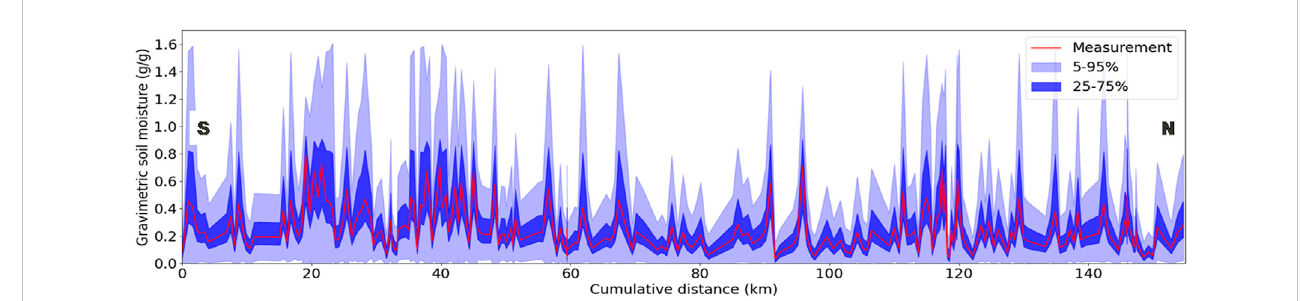
FIGURE 3 Soil moisture measurements with quanti fi ed uncertainties ( fi fth, 25th, 75th, and 95th percentiles) along driven distance.